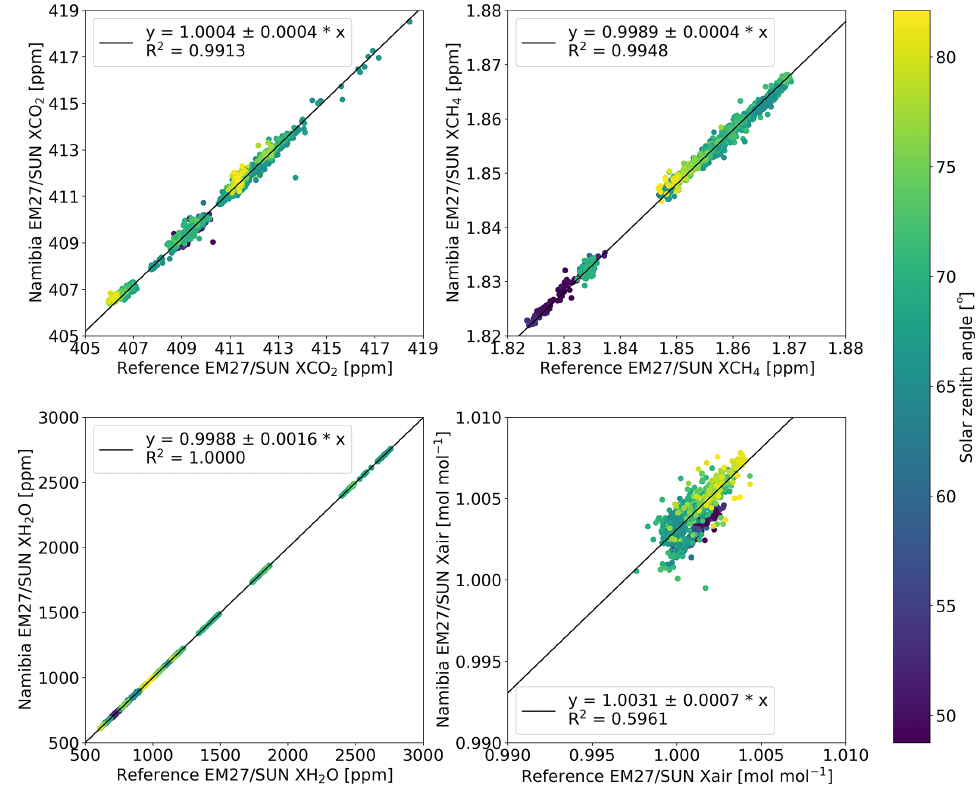
Figure A1. Same as Fig. 4 but for calibration measurements performed between February 2018 and February